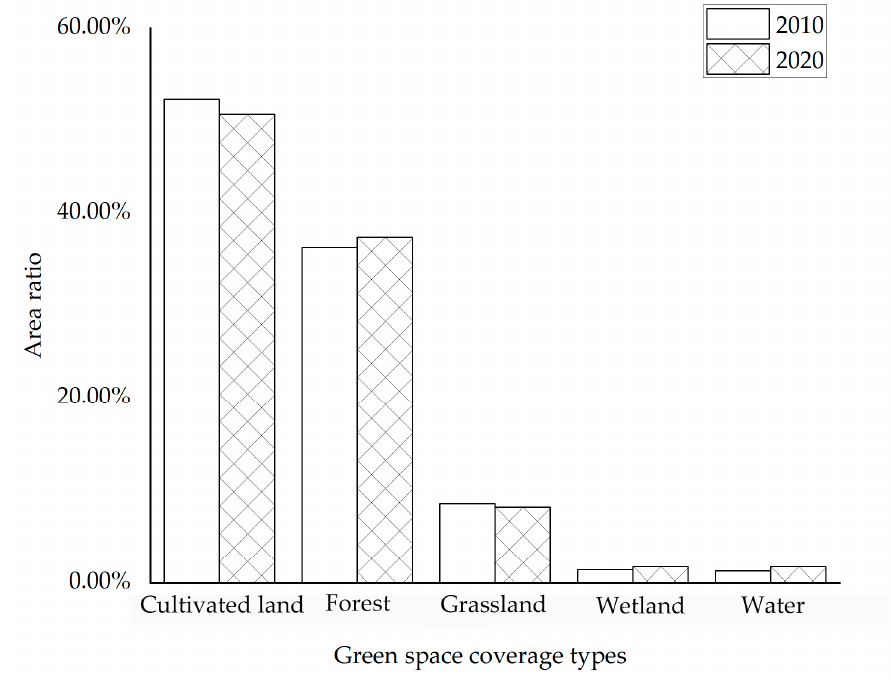
Figure 3. Land cover gain from 2020 to 2010. ( a ) Land cover gain in urban Harbin from 2020 to 2010. ( b ) Land cover gain at the junction of Tonghe, Yilan and Fangzheng counties from 2020 to 2010.